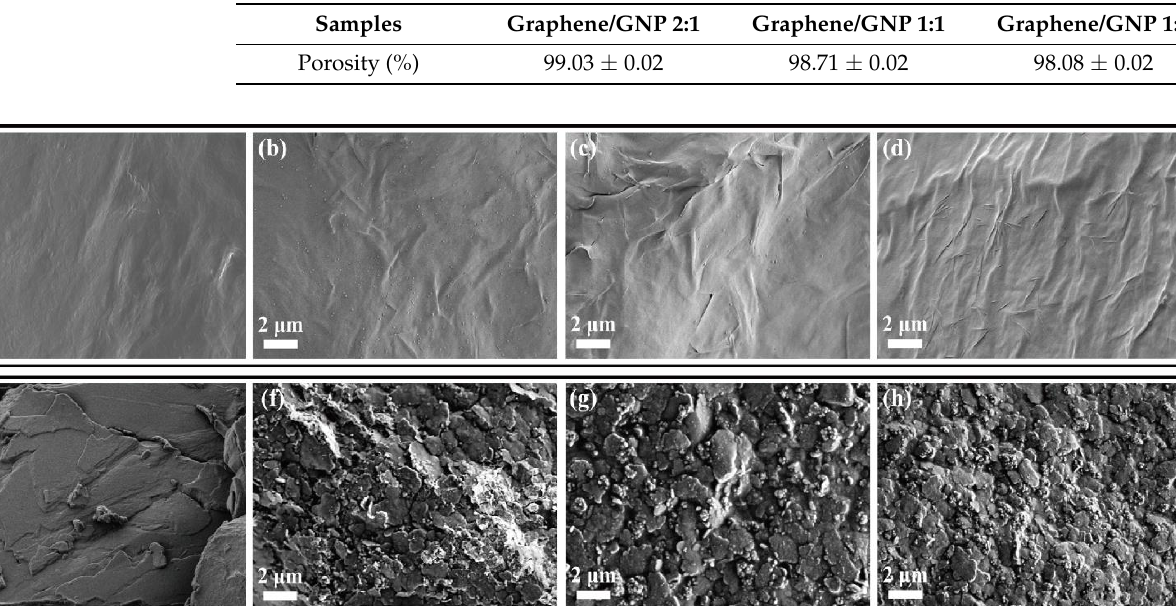
Figure 6. SEM images of ( a ) pure PEG, ( b ) 2:1 PEG composite, ( c ) 1:1 PEG composite, ( d ) 1:2 PEG composite, ( e ) pure 1-TD, ( f ) 2:1 1-TD composite, ( g ) 1:1 1-TD composite and ( h ) 1:2 1-TD composite.